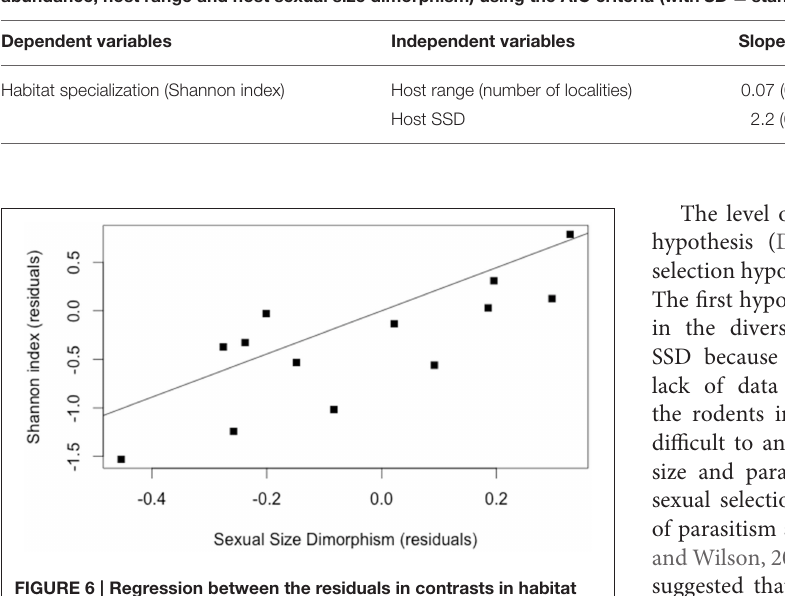
richness as proposed by Getty (2002), who emphasized that fit males are able to maintain both good health condition and more parasites than unhealthy